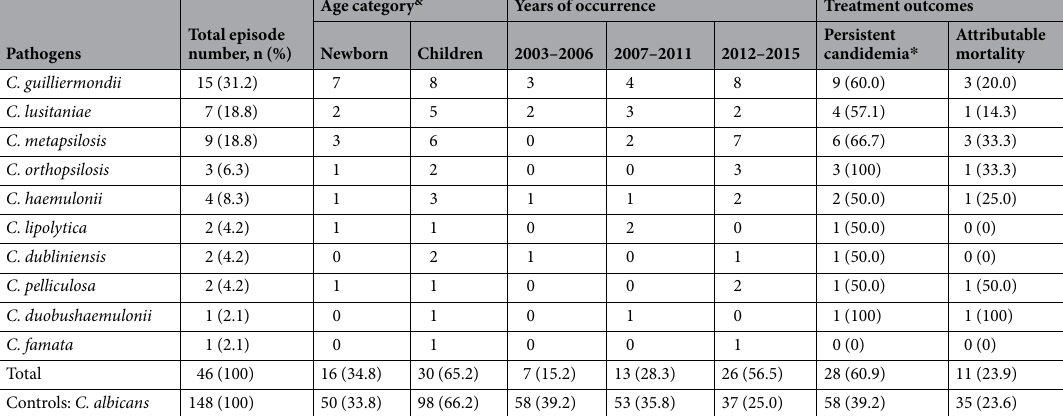
Table 1. The uncommon Candida species causing 46 episodes of candidemia in children. & Newborn: from neonatal intensive care unit, age < 3 months old; children: ward or pediatric intensive care unit, age